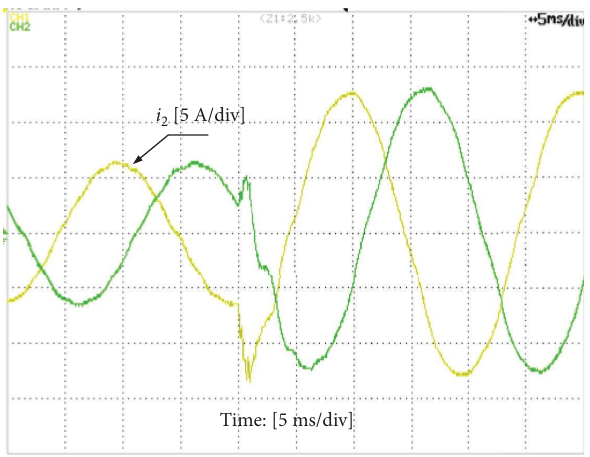
Figure 15: Measured waveforms of grid currents with reference step when L g � 3.6mH and C g � 2 μ F.